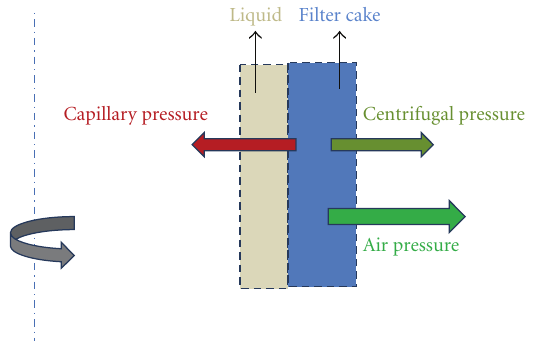
Figure 1: Schematic illustration of three acting pressures on the cake in the novel centrifuge at a given moment.